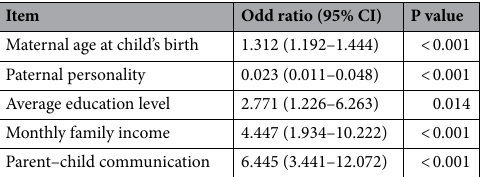
Table 2. Independent familial risk factors for developmental speech delay in children according to the multivariable logistic regression